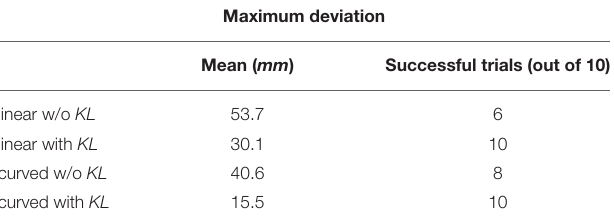
TABLE 1 | Simulation